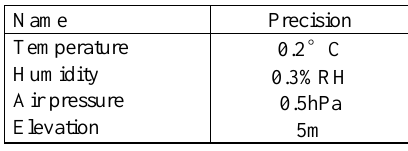
Table 2. Parameters of Portable